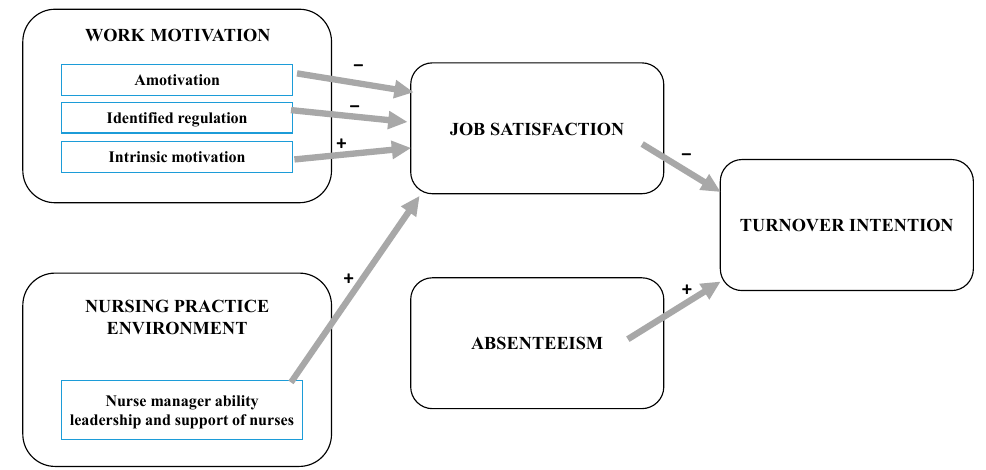
Figure 1. Conceptual model based on the impact of predictors that influence nurses’ turnover inten- tion.